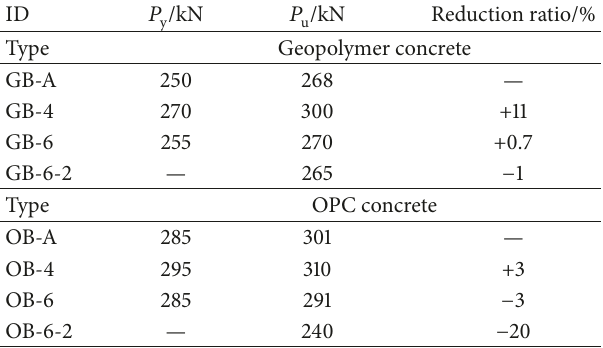
Table 5: Flexural bearing capacity of simply supported